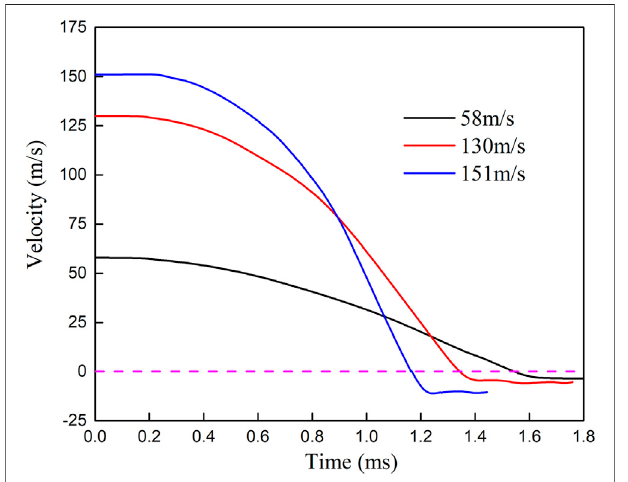
FIGURE 11 | Velocity change curves of the projectile at various impact speeds.